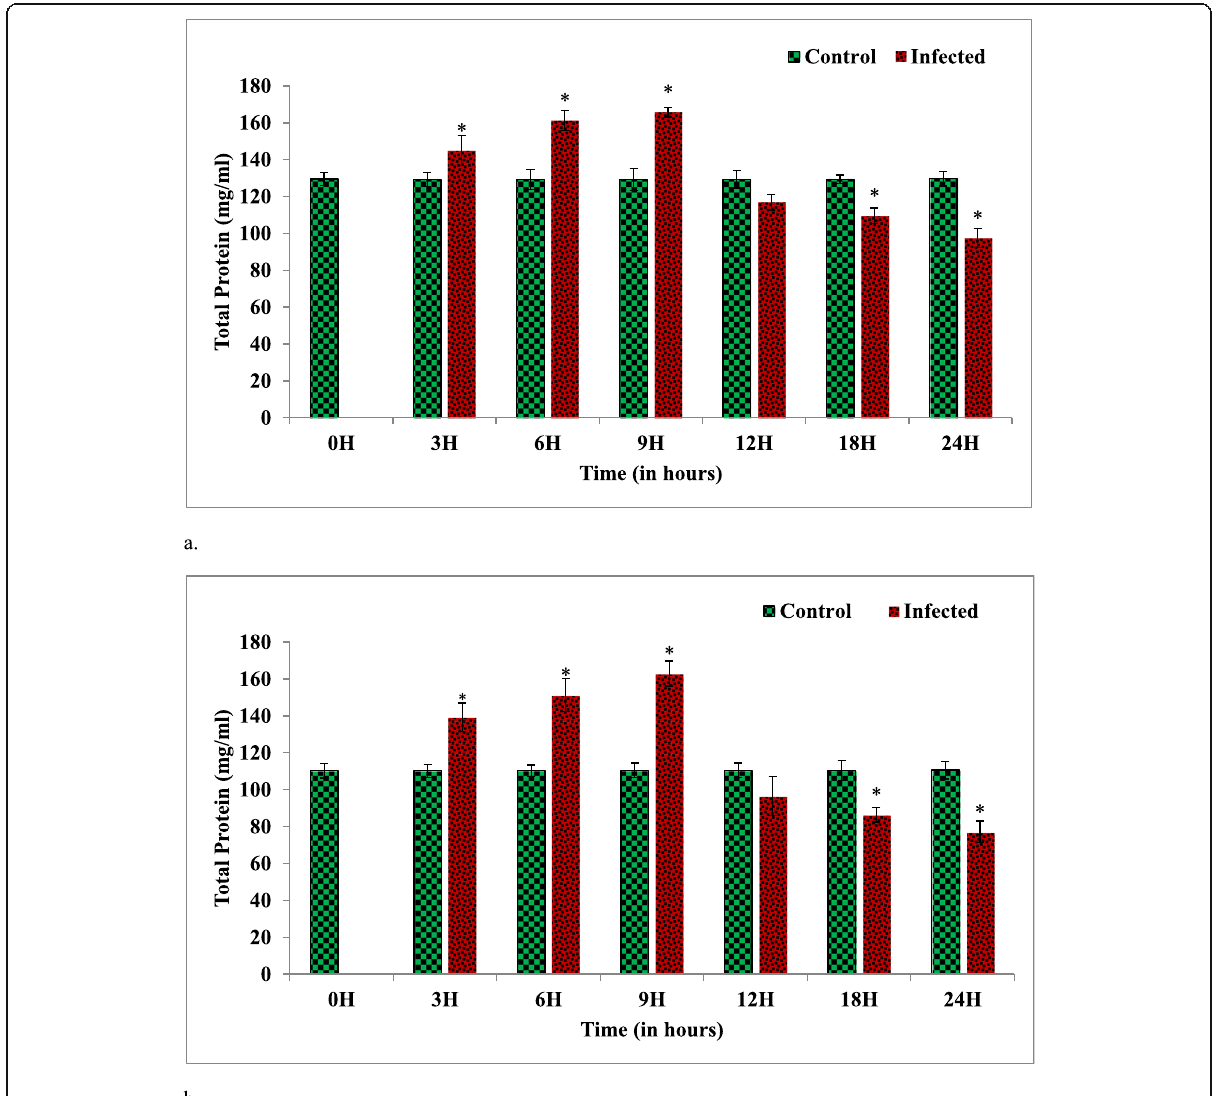
Fig. 1 Concentration of total protein in larval hemolymph ( a ) and plasma ( b ) of Helicoverpa armigera infected with Steinernema abbasi - Xenorhabdus indica complex at different 0, 3, 6, 9, 12, 18, and 24 h. Error bars indicate SEM. The asterisk above the error bars showed that the data was statistically significant at pairwise difference (Fisher ’ s